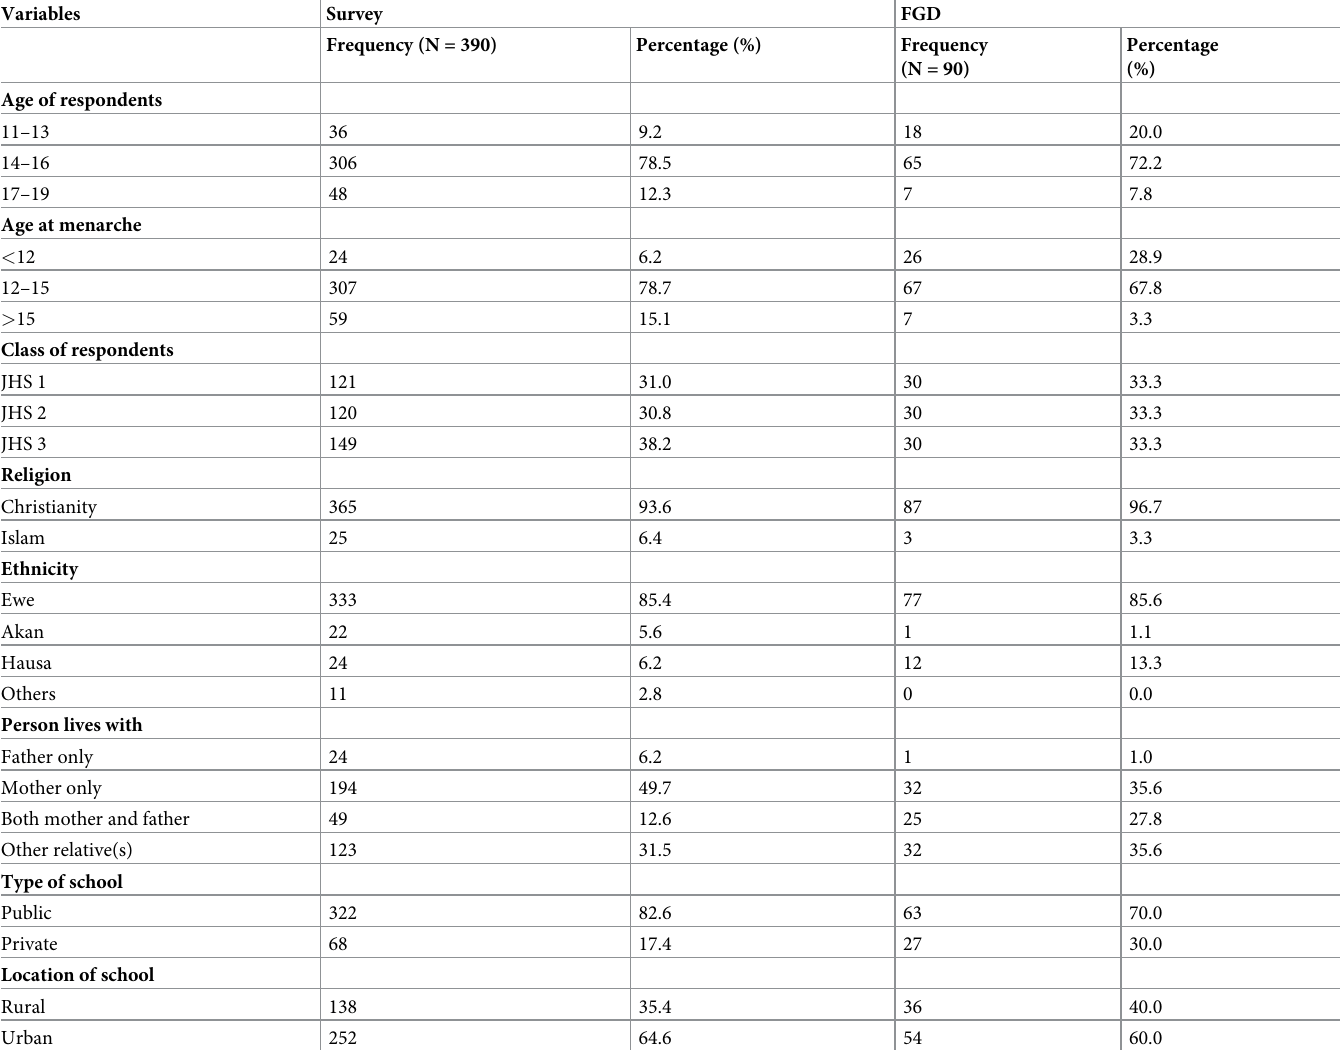
Table 1. Socio-demographic characteristics of the